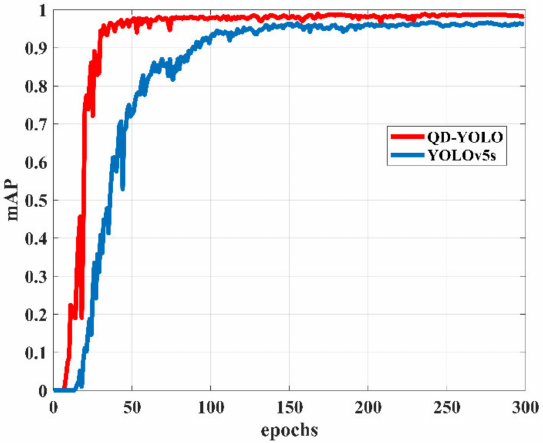
Figure 8. Comparison of mAP values in network training before and after